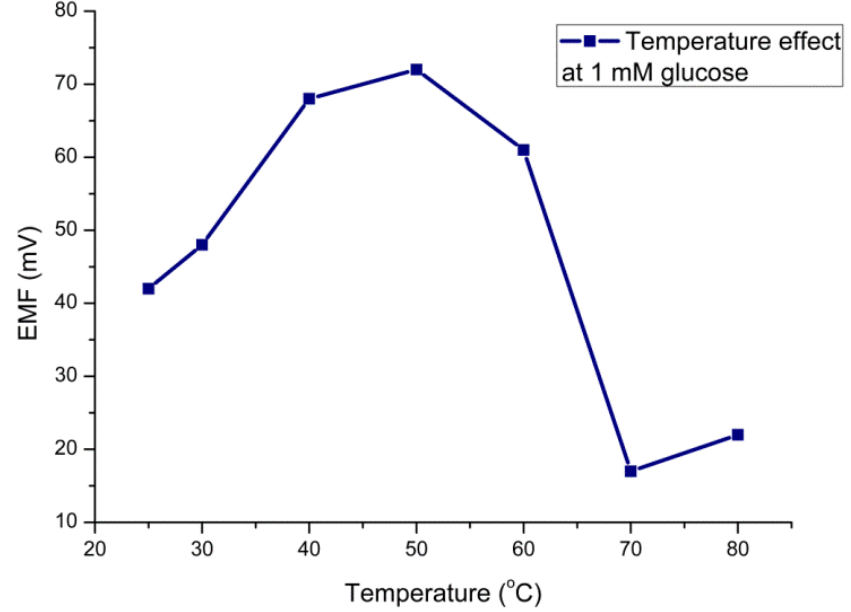
Figure 4. The temperature effect on the potentiometric response of biosensor